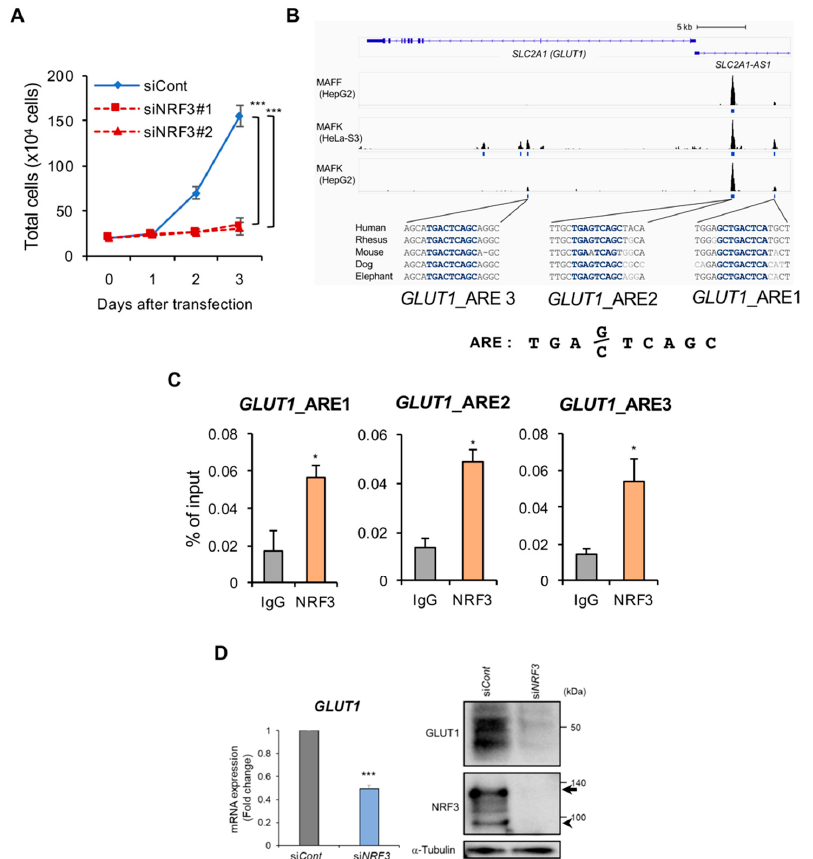
Figure 4. NRF3 activates cell proliferation and GLUT1 gene expression in cancer cells. ( A ) NRF3 knockdown significantly reduced the proliferation of HCT116 cells. The cells were transfected with control siRNA or NRF3 siRNA#1 or #2. At 1-3 days after transfection, the cell numbers were counted using a hemocytometer. The initial cell numbers at the time of transfection were 1 × 10 5 . The data are presented as the mean ± SD ( n = 3). *** p < 0.005 (ANOVA / Tukey). ( B ) Three species-conserved ARE sites (NRF3 recognition sequence) were present in the promoter region and the second intron of the GLUT1 ( SLC2A1 ) gene. ChIP-seq data (SRX150386, SRX150370, SRX150689) in the ChIP-Atlas database show the binding of MAFF and MAFK as heterodimer partners of NRF3 to the AREs in the GLUT1 gene. The blue bars represent the peak regions. The ARE sequences in the human gene are highly conserved among several species (blue). ( C ) ChIP analysis using HCT116 cells revealed NRF3 binding to three ARE sequences in the GLUT1 gene. * p < 0.05 ( t -test). ( D ) NRF3 knockdown attenuated GLUT1 gene expression at both the mRNA and protein levels. NRF3 siRNA was transfected into HCT116 cells, and GLUT1 gene expression was determined by qRT-PCR at 48 h after transfection. The arrows and arrowheads in the immunoblot indicate the cytoplasmic and nuclear forms of NRF3, respectively. RNA expression levels were normalized to β -actin expression, and data are presented as the mean ± SD ( n = 3). *** p < 0.005 ( t -test).